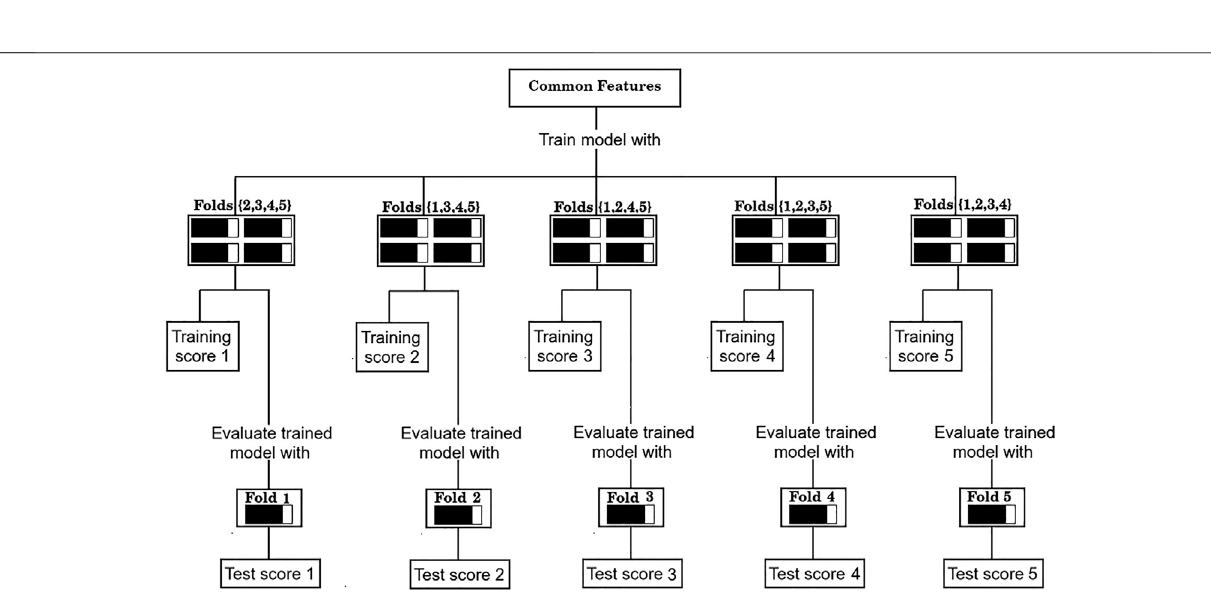
Frontiers in Chemistry |